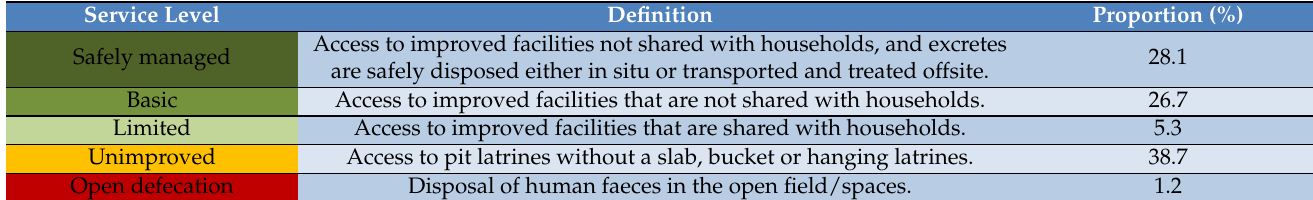
Table 8. The households’ sanitation facilities access services ladder.